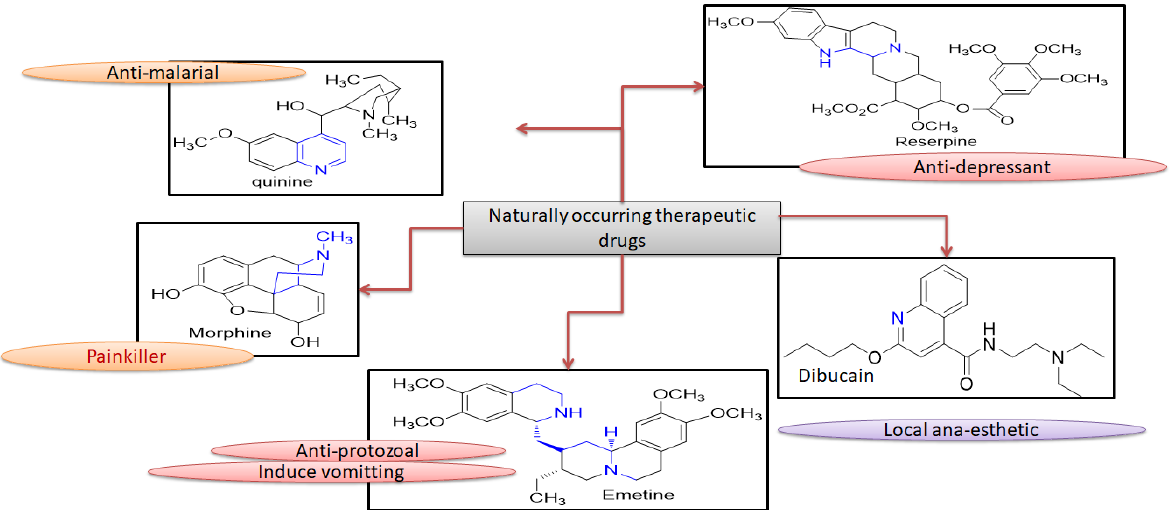
Figure 1. Naturally occurring therapeutic drugs with their potentials.